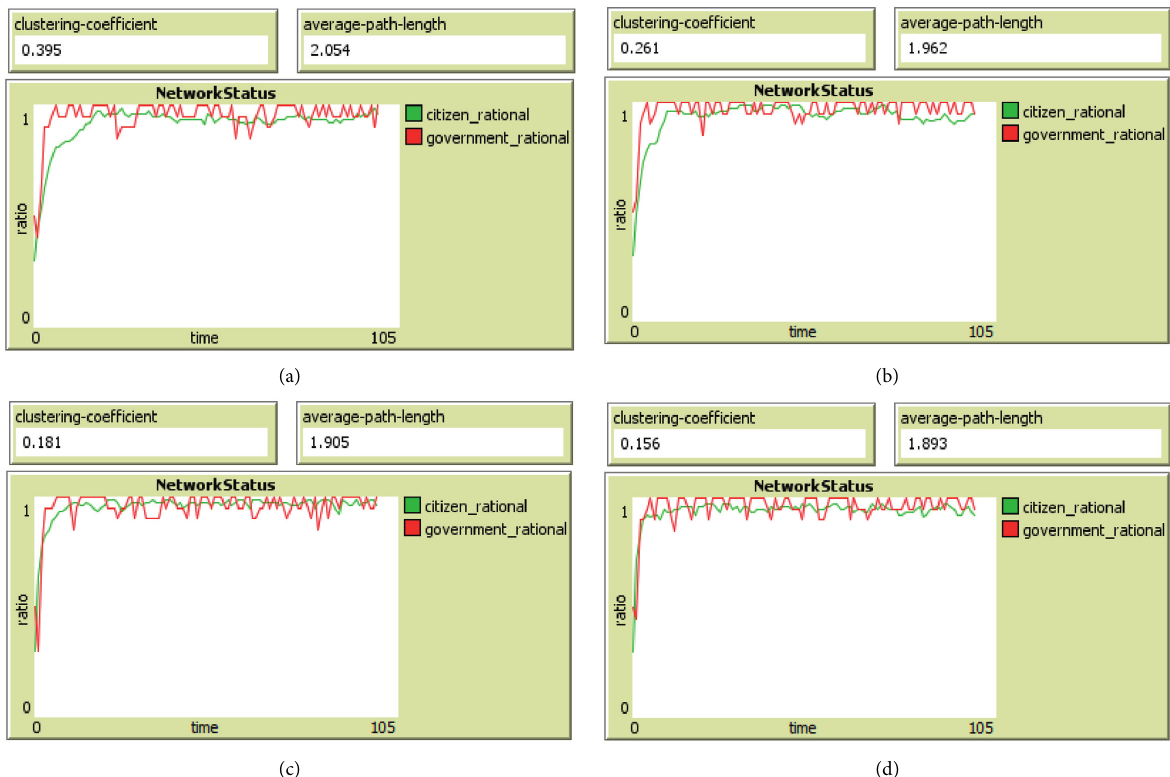
Figure 4: The evolutionary results when the reconnection probability p takes different values in scenario one: (a) the evolutionary result when p � 0.2; (b) the evolutionary result when p � 0.4; (c) the evolutionary result when p � 0.6; (d) the evolutionary result when p �